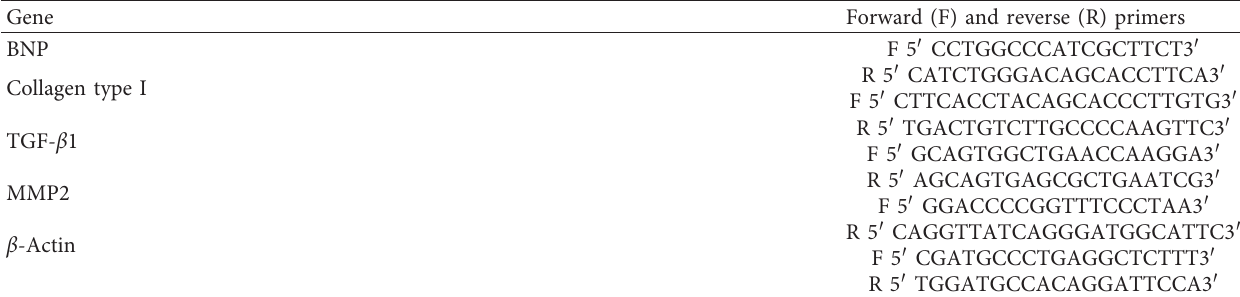
Table 1: Primer sequences for quantitative real-time